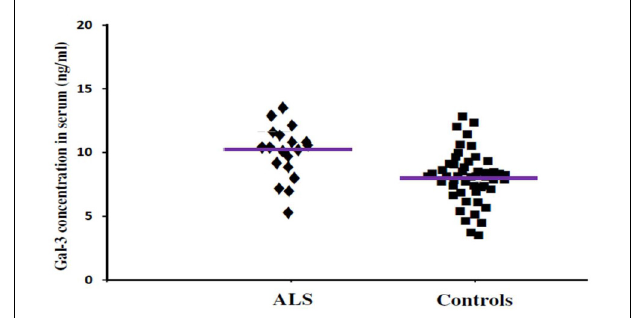
FIGURE 3 | The concentrations of Gal-3 in serum (ng/mL) of ALS patients and healthy controls. ALS patients showed enhanced Gal-3 concentrations in serum as compared to the healthy controls (ALS vs. healthy controls [mean ± SD] 10.45 ± 3.48 vs. 8.76 ± 3.03 ng/mL; P = 0.019).